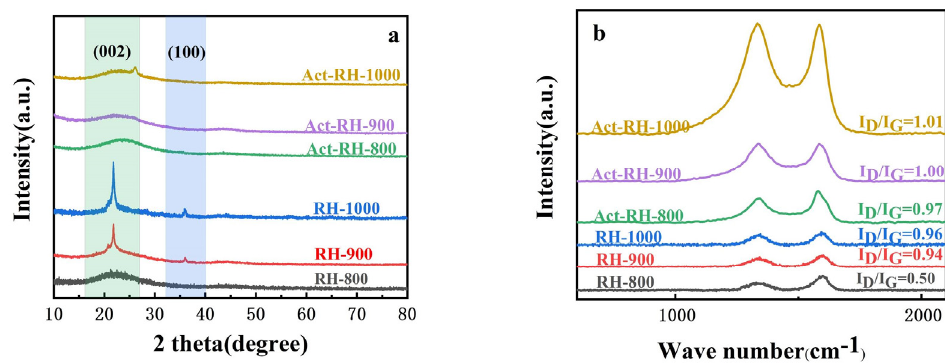
Figure 4. ( a ) XRD patterns and ( b ) Raman spectra of the investigated samples.